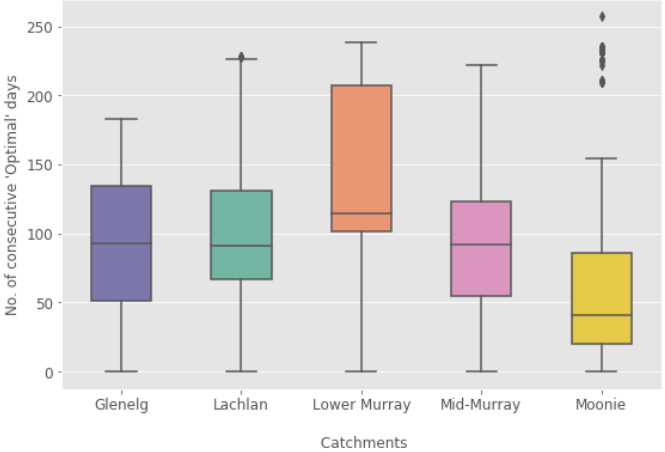
Figure 9. Summary box plot of the number of consecutive days with water temperature in the permissible range of virus activity.